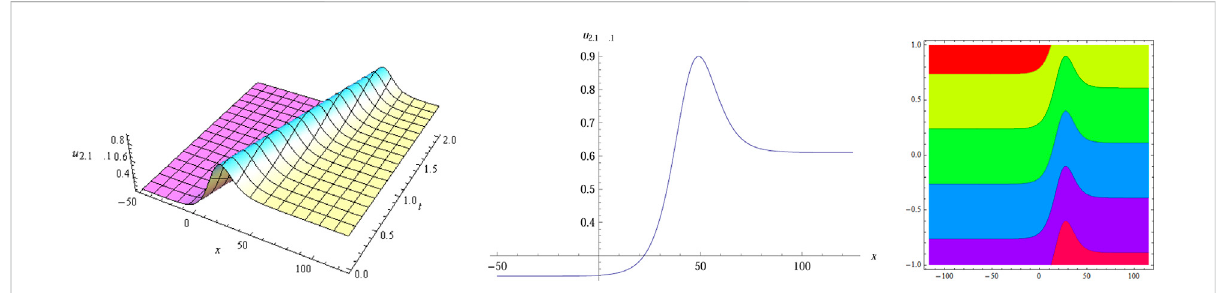
FIGURE 1 3D plot, 2D plot, and contour plot of u 2 . 1 . 1 with α (cid:2) 1 , β (cid:2) 1.